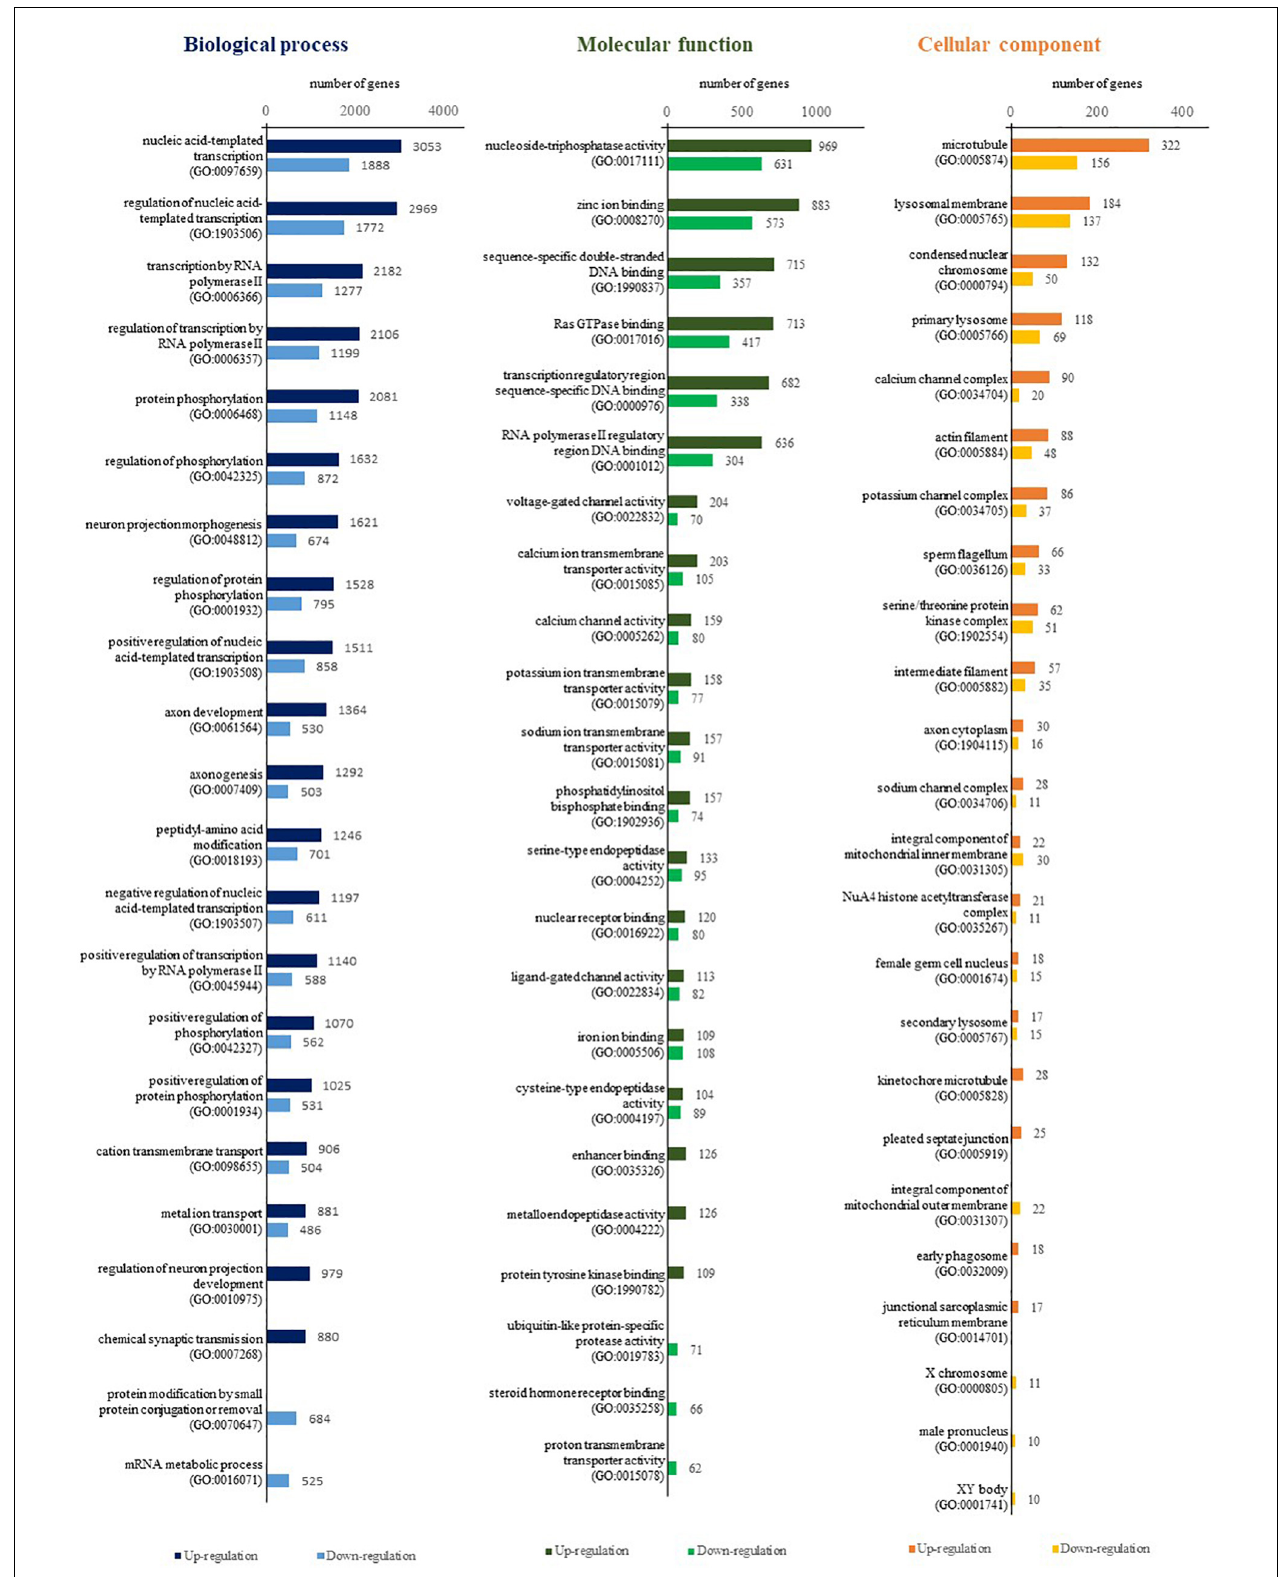
FIGURE 2 | Comparison of GO annotation (by level 7) for functional analysis of DEGs between A. baenschi albino-type and wild-type.